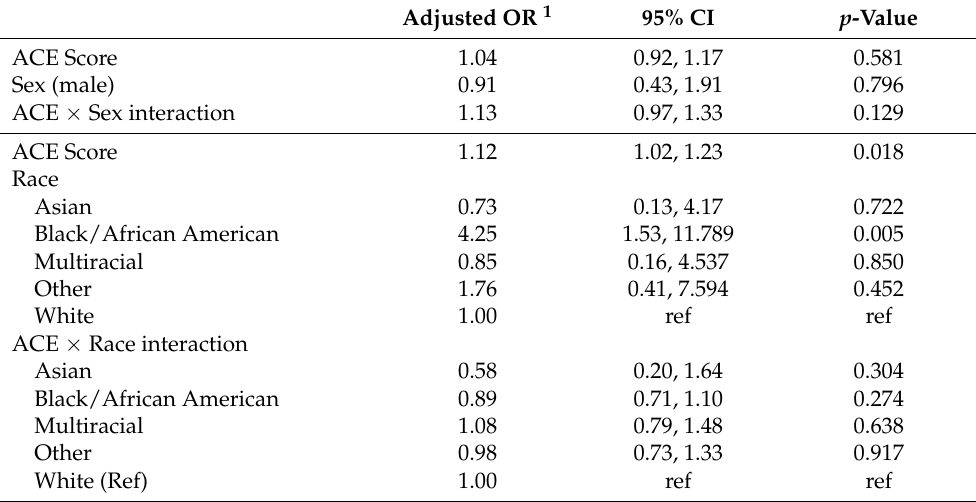
Table 3. Associations between ACE score and having at least one ED visit within the 12 month study window, interaction by sex and race.